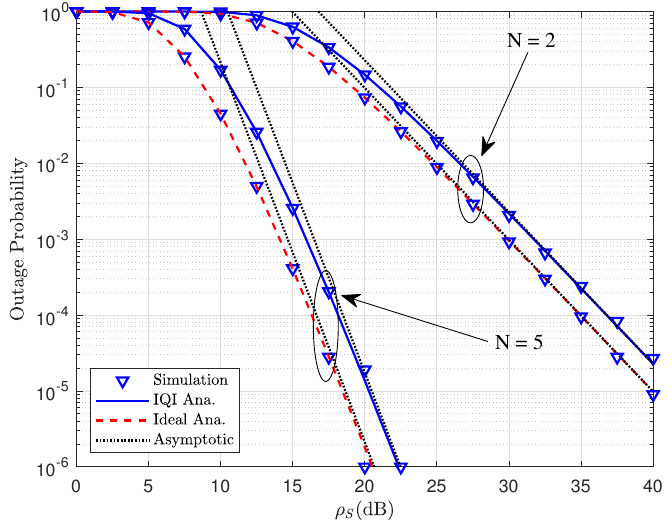
Figure 5. The outage probability vs. ρ S (dB) with varying N for RIS-T